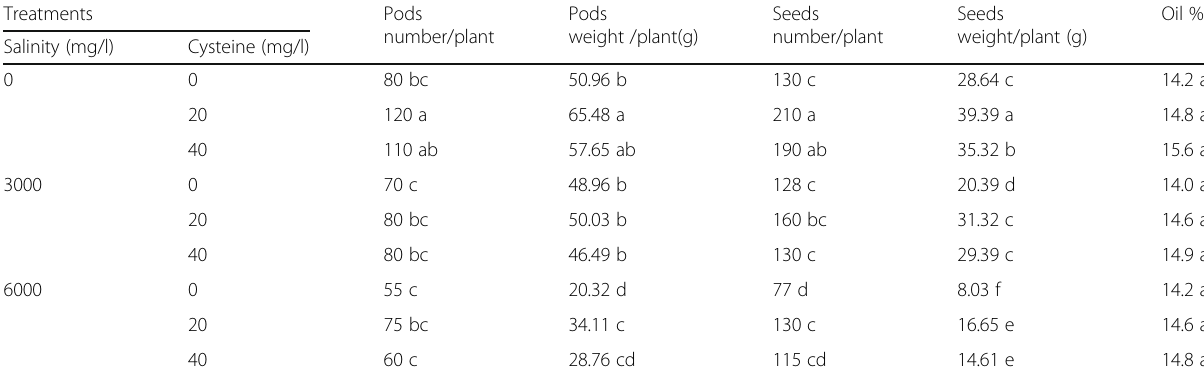
Mean values ( n =3) in each column followed by a different letter are significantly different at ≤ 0.05 by Duncan ’ s multiple range